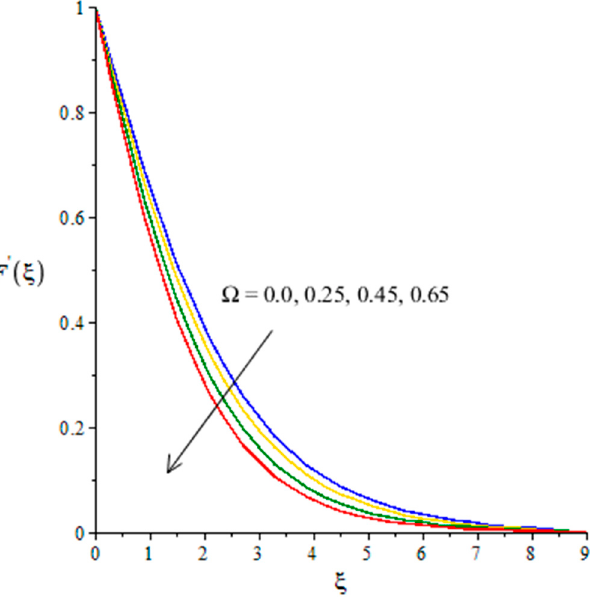
Figure 11. Variation role of F (cid:48) ( ξ ) versus Ω when m = 0.01, We = 7, M 2 = 0.1, β e = 0.7, β i = 0.31, Figure 11. Variation role of 𝐹′(𝜉) versus Ω when 𝑚 = 0.01,𝑊𝑒 = 7, 𝑀 (cid:2870) = 0.1, 𝛽 (cid:3032) = 0.7, 𝛽 (cid:3036) = (cid:101) = 0.04, F r = 3.0, Pr = 204, Ec = 0.34, ϕ 2 = 0.0075, ϕ 1 = 0.002, ϕ 3 = 0.31, 𝜖 = 0.04, 𝐹 (cid:3045) = 3.0, 𝑃𝑟 = 204, 𝐸𝑐 = 0.34, 𝜑 (cid:2870) = 0.0075, 𝜑 (cid:2869) = 0.002,𝜑 (cid:2871) = 0.005.